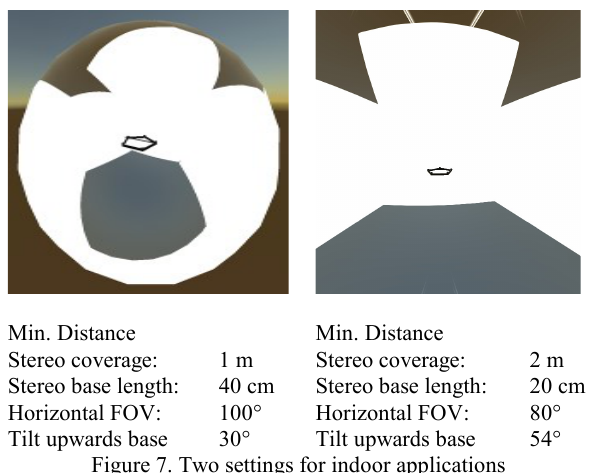
Figure 7. Two settings for indoor applications